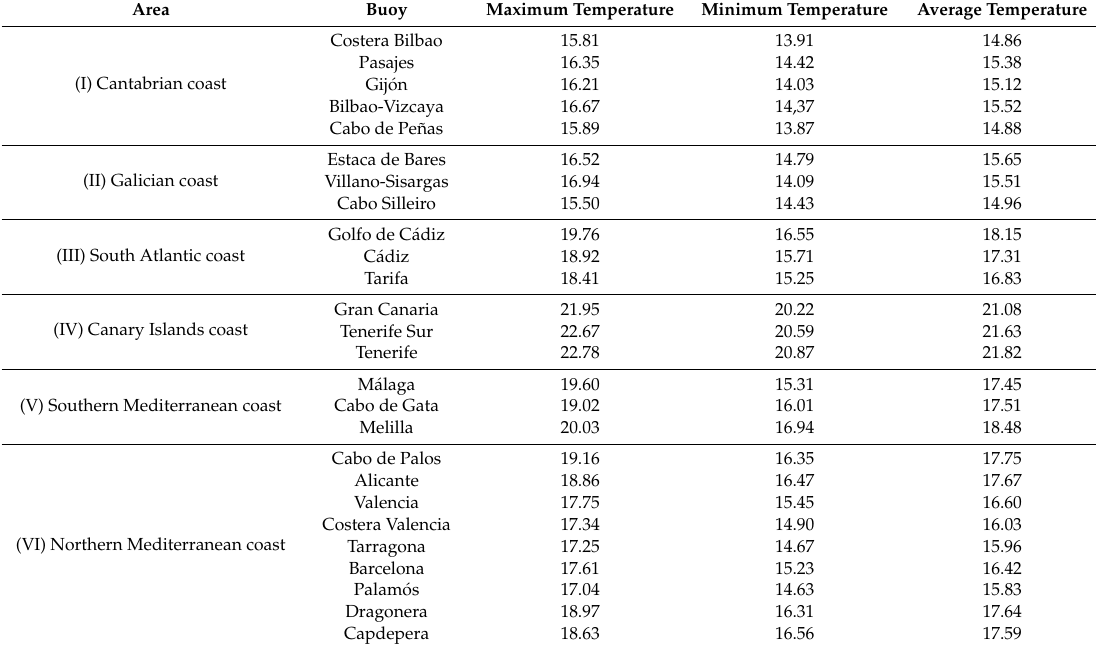
Table 5. Temperature data, in degrees, in “Puertos del Estado” buoys, in all the areas in the Spanish coast. Area Buoy Minimum